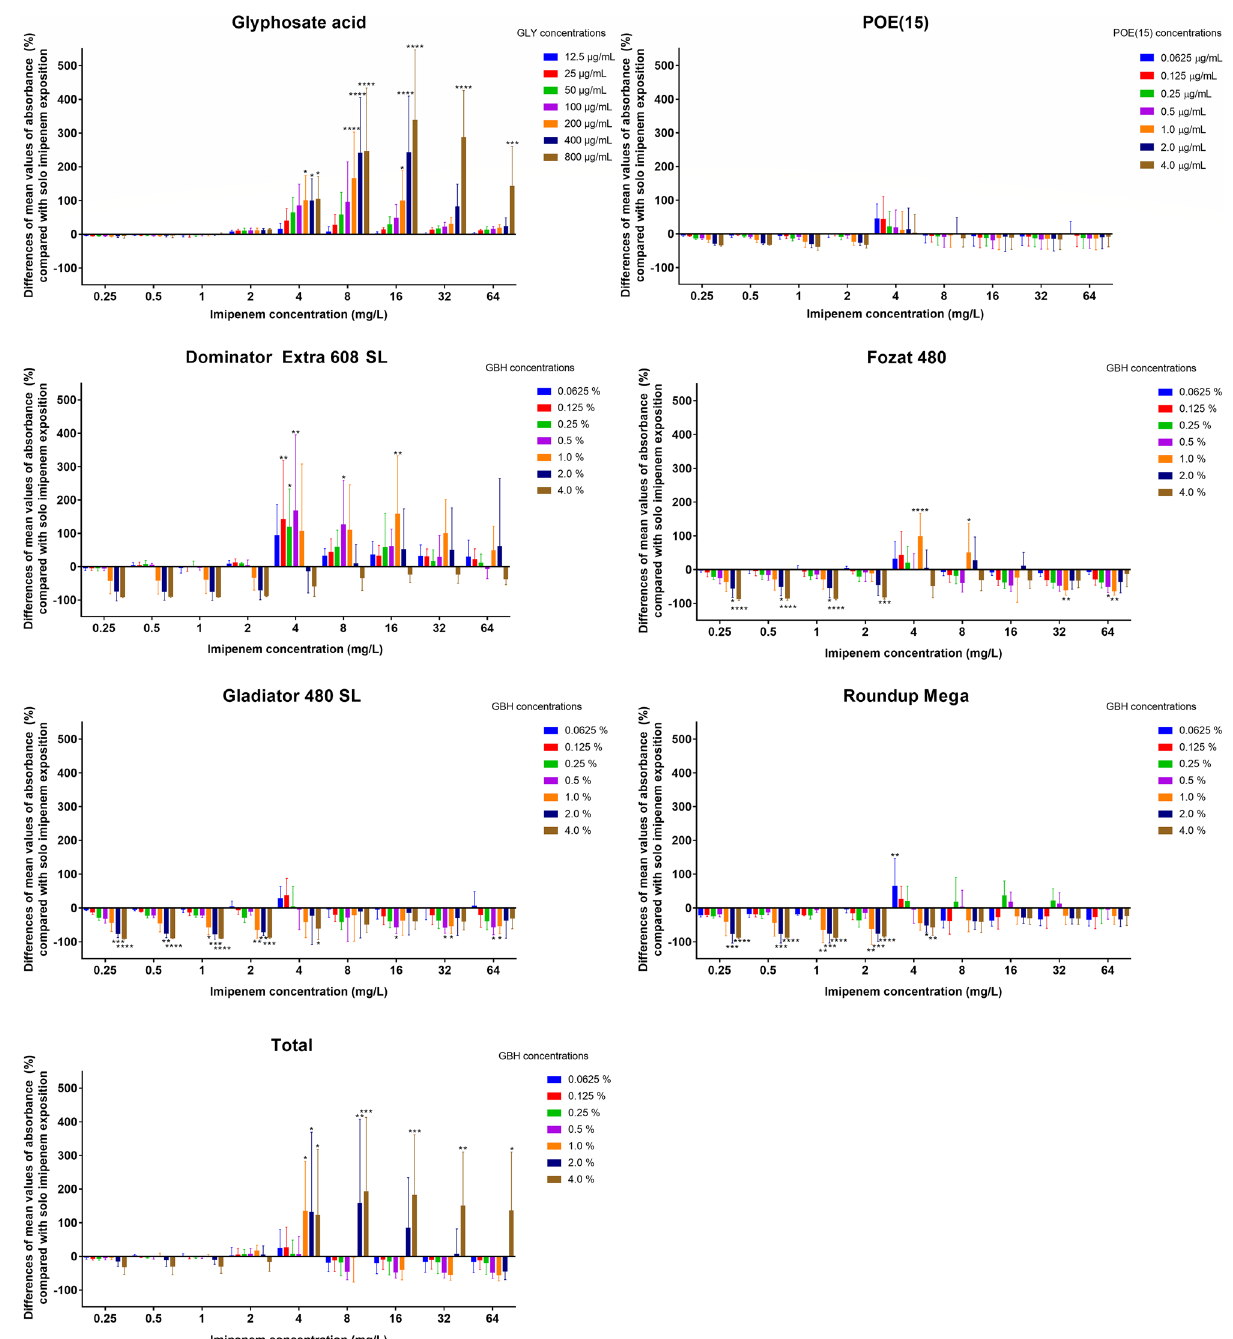
Figure 3. Summarized average differences of absorbance values (%) of all the examined five P. aeruginosa strains under co-exposition to imipenem with GLY, POE(15), and GBHs, compared with the absorbance values of solo imipenem exposition. X-axis: imipenem concentrations (0.25–64 mg/L) and seven concentrations of each test material (GLY: 12.5–800 mg/L, POE(15): 0.0625–4.0 mg/L, GBHs: 0.0625–4.0% (v/v)). Positive range—intensification; negative range—inhibition. Each bar represents the average absorbance value of five P. aeruginosa strains co-exposed to imipenem and test materials in three independent experiments. Two-way ANOVA and Dunnett’s multiple comparisons tests were used. *, **, *** and ****Significantly different from solo imipenem values (p < 0.0332, p < 0.0021, p < 0.0002 and p < 0.0001,